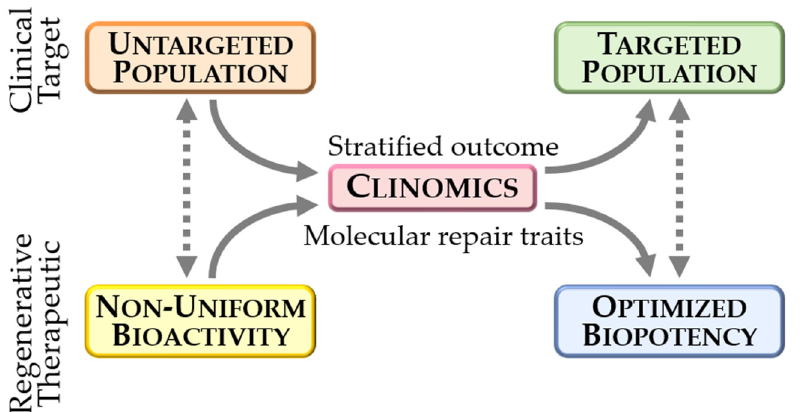
Figure 2. Convergence of new knowledge distilled from clinical trials and regenerative science has expedited the stratification of responders versus non-responders to biotherapy while decoding the molecular underpinnings associated with repair capacity. The era of “clinomics” leverages clinically available biospecimens, including clinical trial biobanked stem cells, to help resolve through ‘omics methodologies the core components underlying therapeutic bioactivity. Iterative, integrated analysis guides the development of next generation biotherapeutics endowed with regenerative biopotency and optimized to achieve consistent outcomes in defined candidate populations.